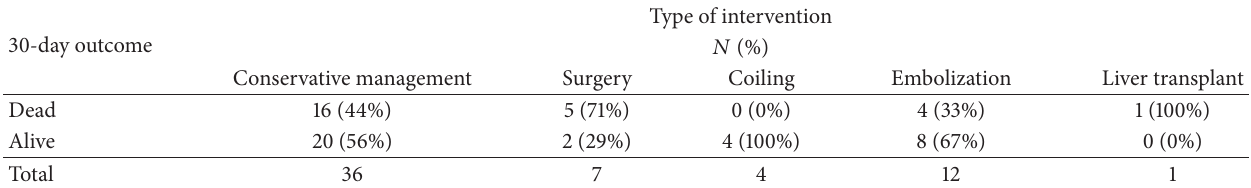
Table 4: Subjects’ 30-day outcome based on type of intervention.